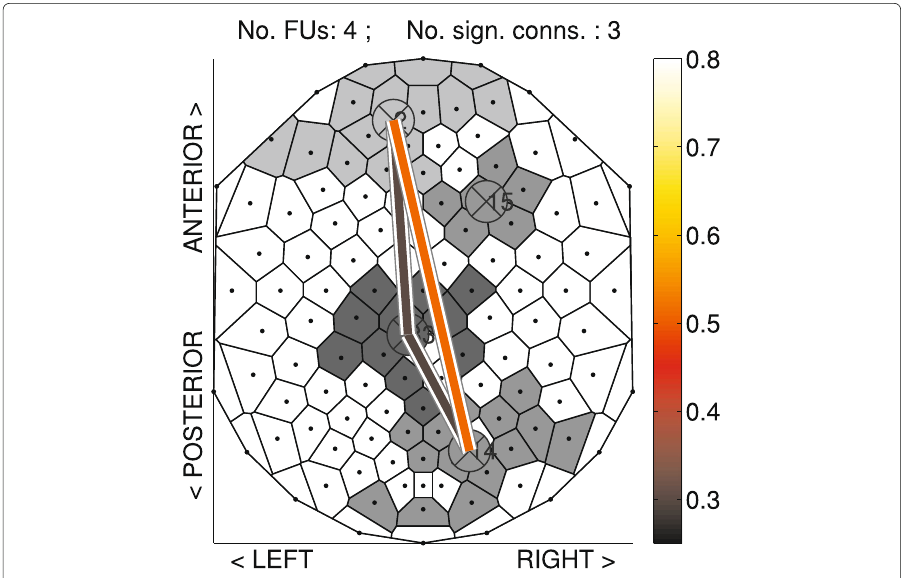
Fig. 7 Example of an FU MCB map (ten Caat 2008) as obtained during an auditory oddball task (see “Experimental setup” section. Spatial groups of similarly colored (in gray scale) cells correspond to FUs with a size of at least four, while white cells are part of smaller FUs. Circles overlayed on the cells represent the barycenters of the FUs and are connected by lines whose color reflects the average coherence between all electrodes of the FUs (see color bar). See ten Caat et al. (2007a) for